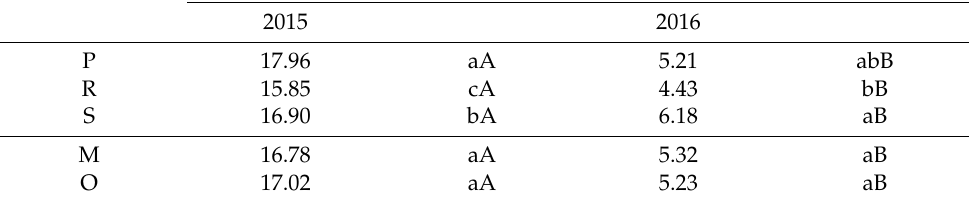
Values belonging to the same treatment with different letters in columns for tillage or fertilization effects (lower case letter), and in rows for year effect (upper case letter) are statistically different according to LSD (0.05). P = Plowing; R = Subsoiling; S = Spading; M = Mineral; O = Organic. Table 3. Labile carbon expressed as percentage to total organic carbon (LC/TOC) and labile nitrogen expressed as percentage to total nitrogen (LN/TN).